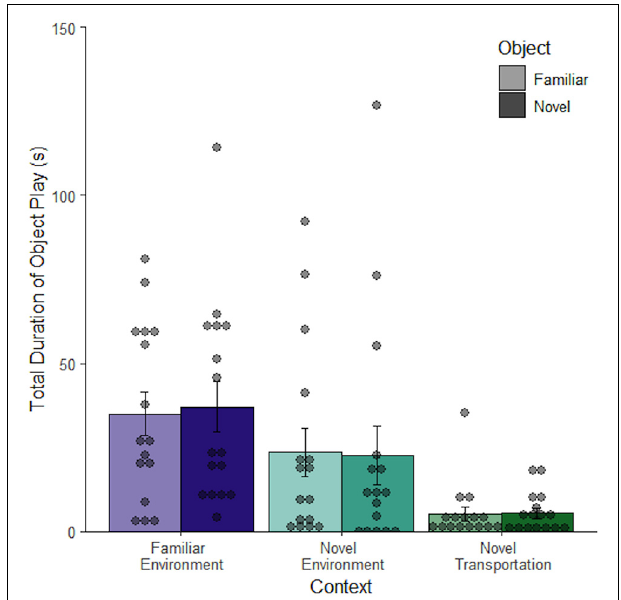
FIGURE 5 | Time spent playing with an object changes depending on context. Rats in a familiar context spend more time playing with an object than rats in a novel context. Novel transportation is also related to decreased mean object play ( n = 96). Error bars report SEM for each group. Points indicate the total duration of object exploration for each subject grouped into bins of 4.2 s.